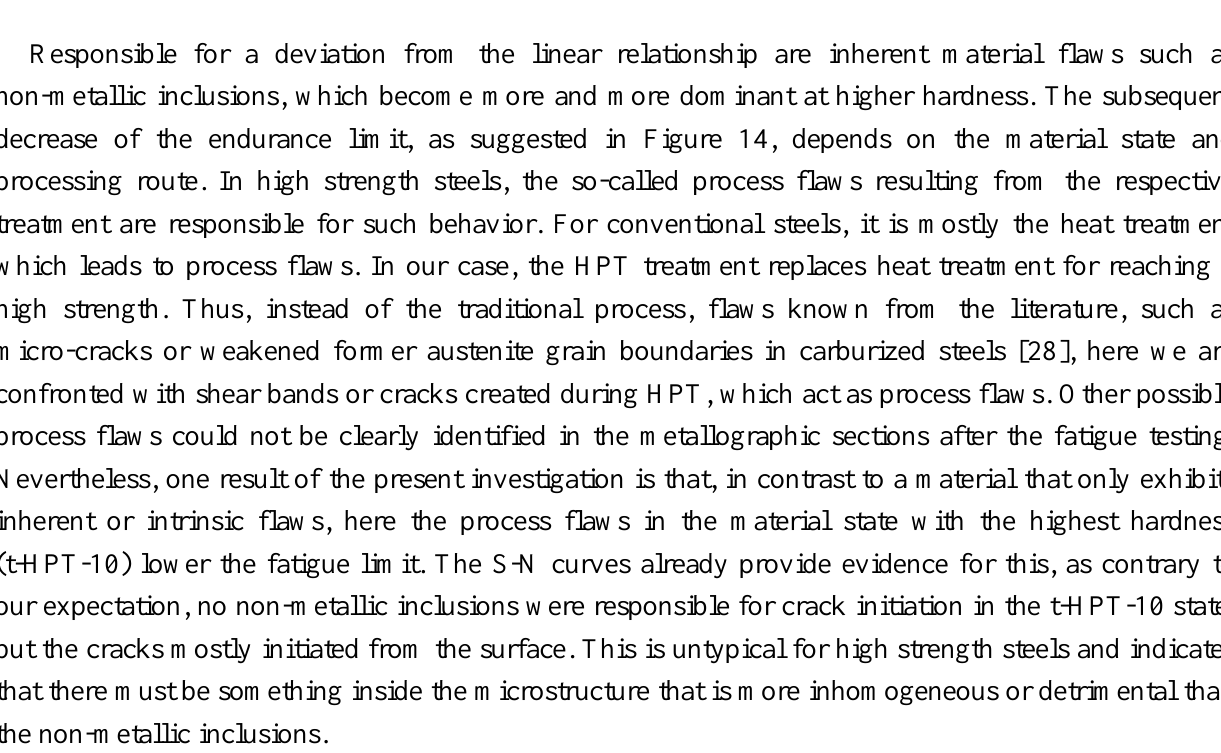
Figure 14. Relationship between hardness and endurance limit revealing a linear